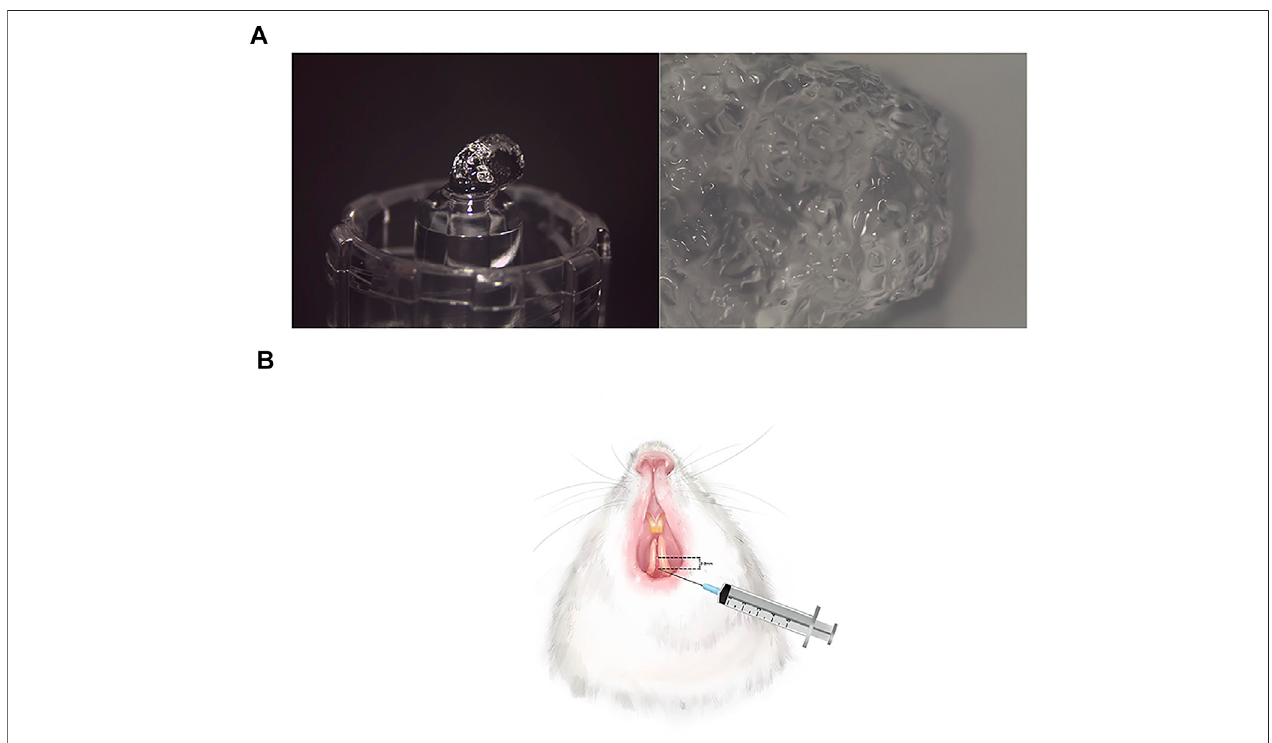
FIGURE1| Theappearance ofHA fi llerand injection procedure. (A) Thepictures ofHA fi llerat × 8magni fi cation and × 12.5 magni fi cation, respectively. TheHA fi ller contains 18 mg/ml modi fi ed HA with pH values 6.8 – 7.5 and particle sizes 0.2 – 0.6 mm. (B) A total of 0.08 ml HA was injected at approximately 2 – 3 mm apically below the interdental papilla